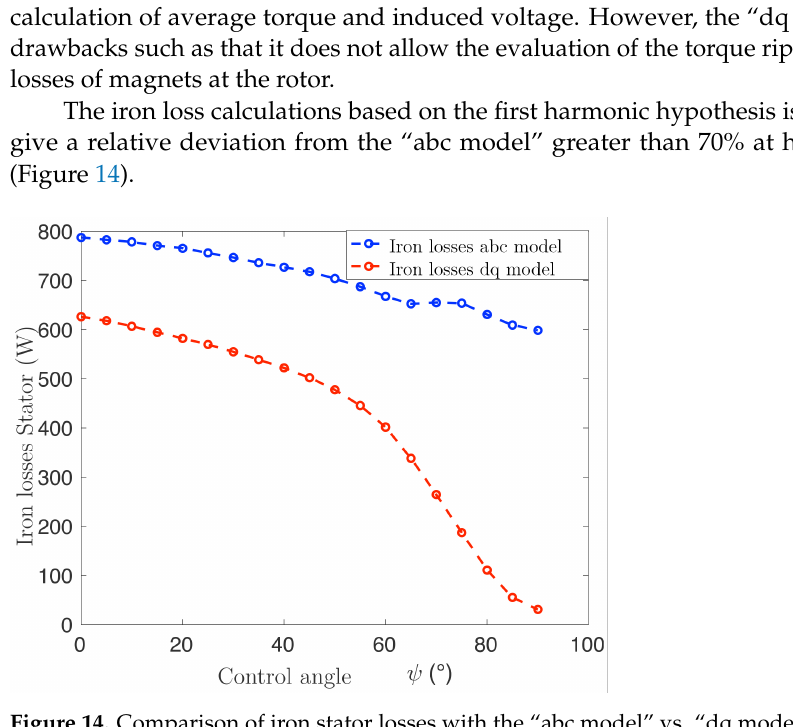
Figure 14. Comparison of iron stator losses with the “abc model” vs. “dq model”.